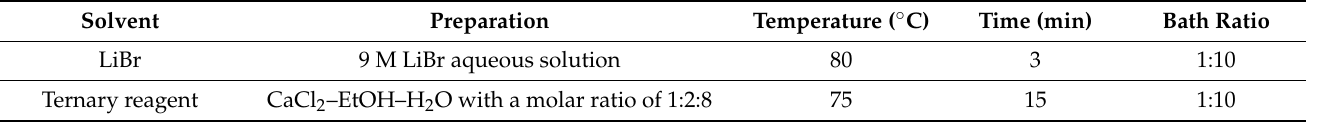
Table 1. Preparation of RSF under controlled